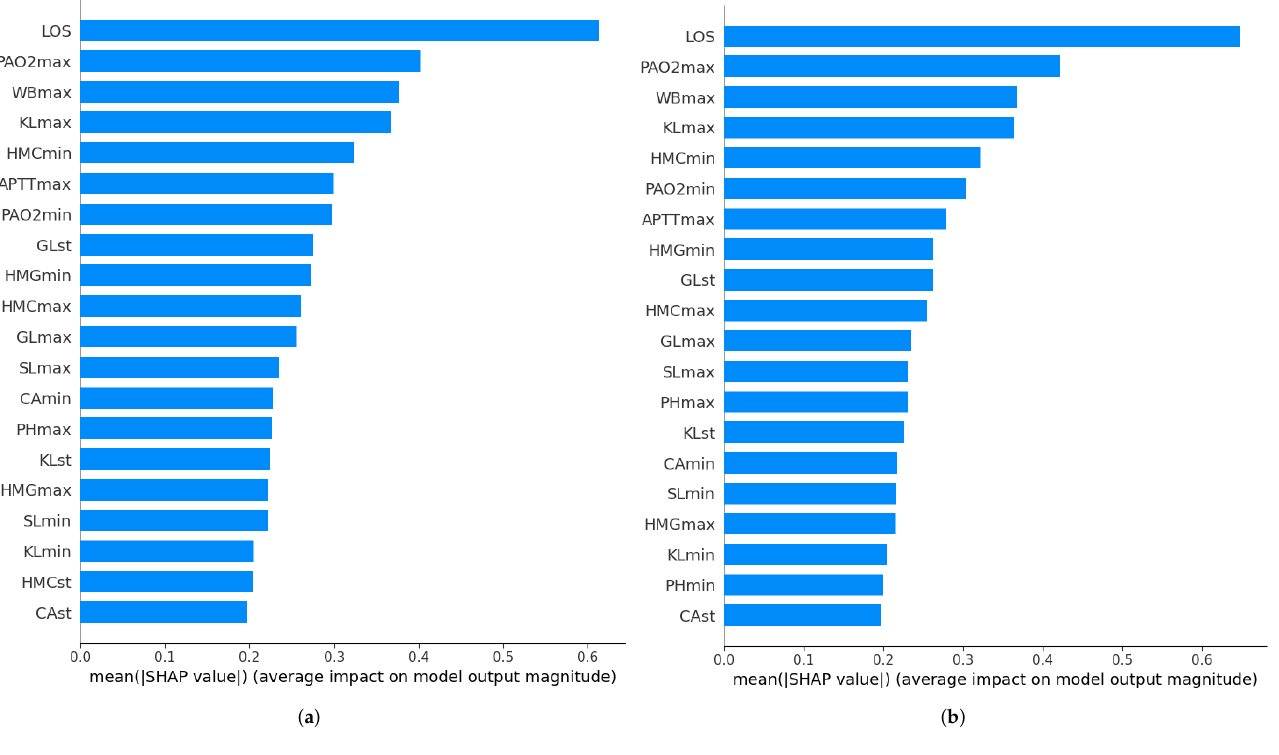
Figure 7. Feature importance using the different optimization criteria: AUROC and AUPRC. ( a ) Using AUROC as an optimization criterion. ( b ) Using AUPRC as an optimization